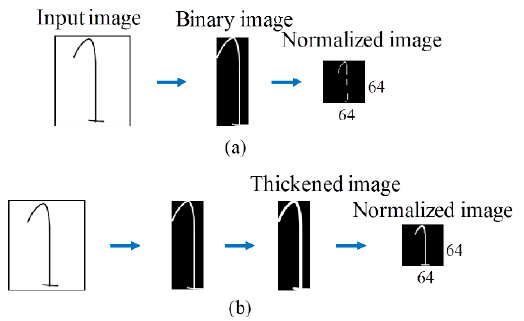
Figure 10. Normalization step on input image: ( a ) Illustration of normalized image without thickening, and ( b ) illustration of normalized image with thickening.